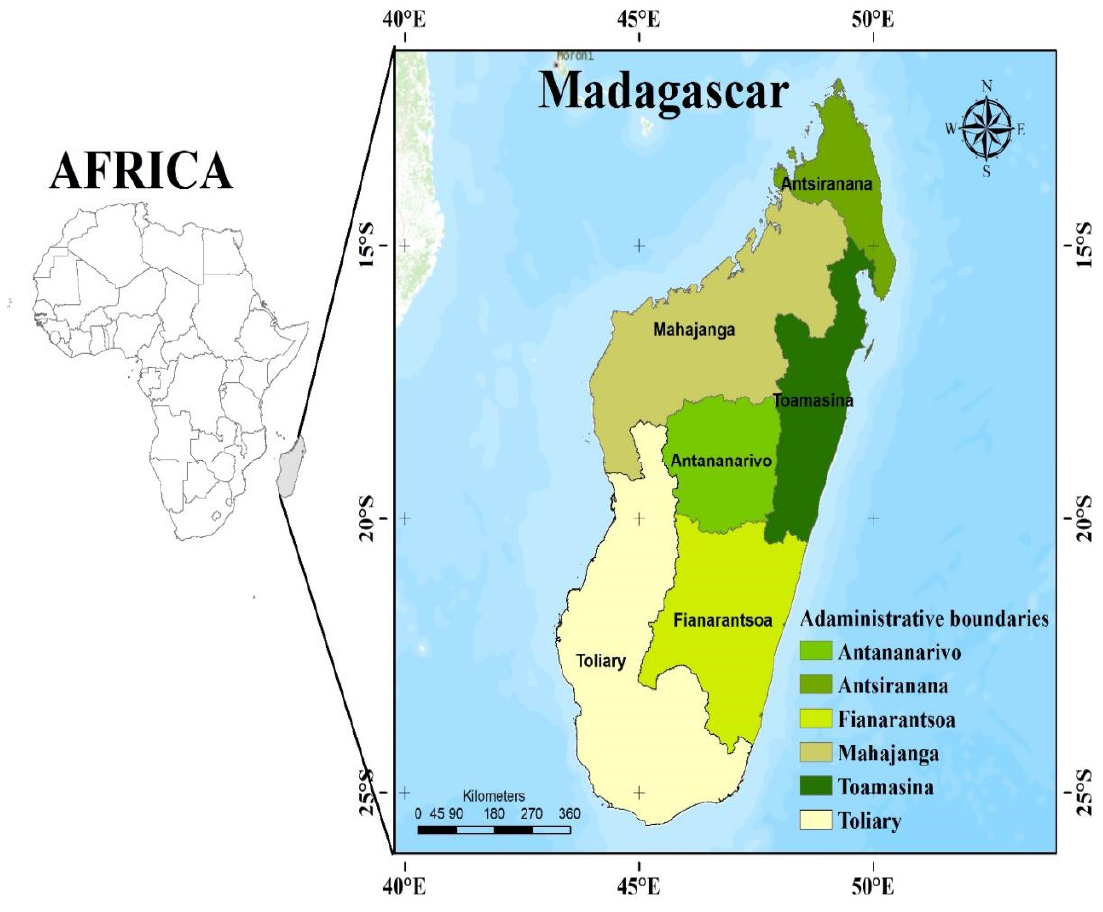
Figure 1. Map showing the location of major provinces in Madagascar and geographical zones (Source: [38,39] ).